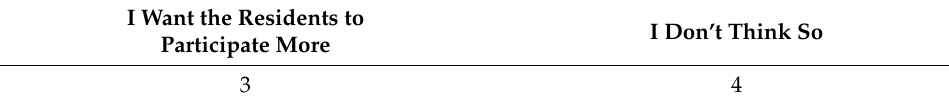
Table 4. HRC members perspectives regarding resident participation in HRC